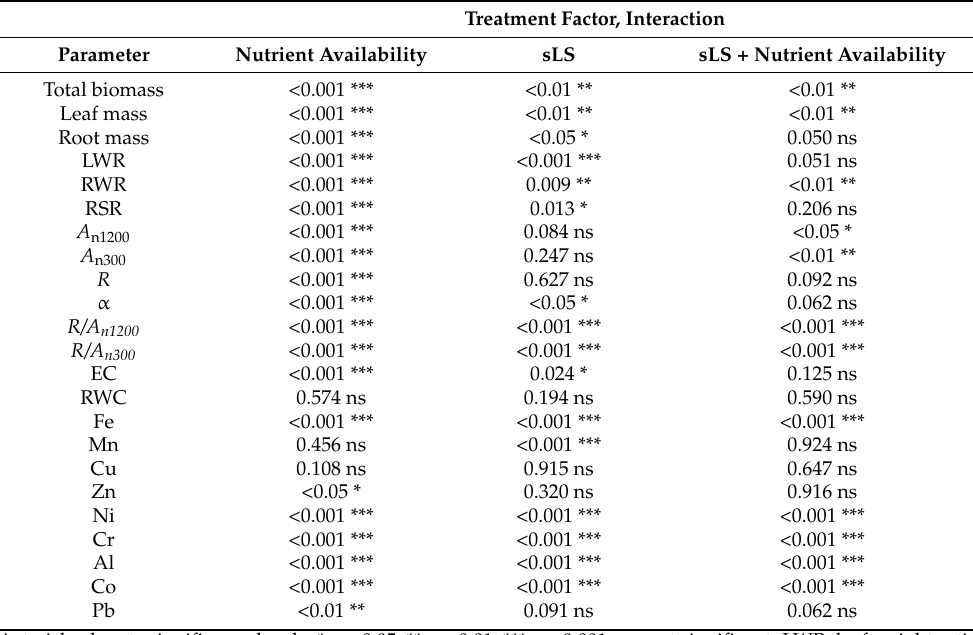
Table 1. The p -values of two-way ANOVA statistical treatment for the parameters depicted in Figures 1–5. Treatment Factor,